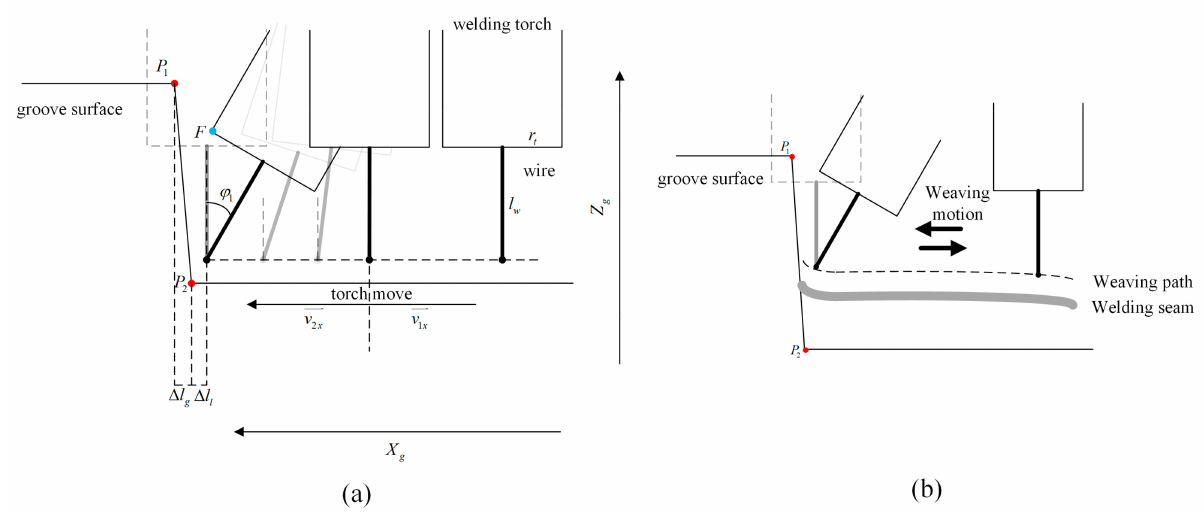
Figure 6. The weaving attitude of welding torch is adjusted to avoid obstacles. ( a ) The motion of the welding torch during welding of the first layer. ( b ) The motion of the welding torch during welding of the remaining